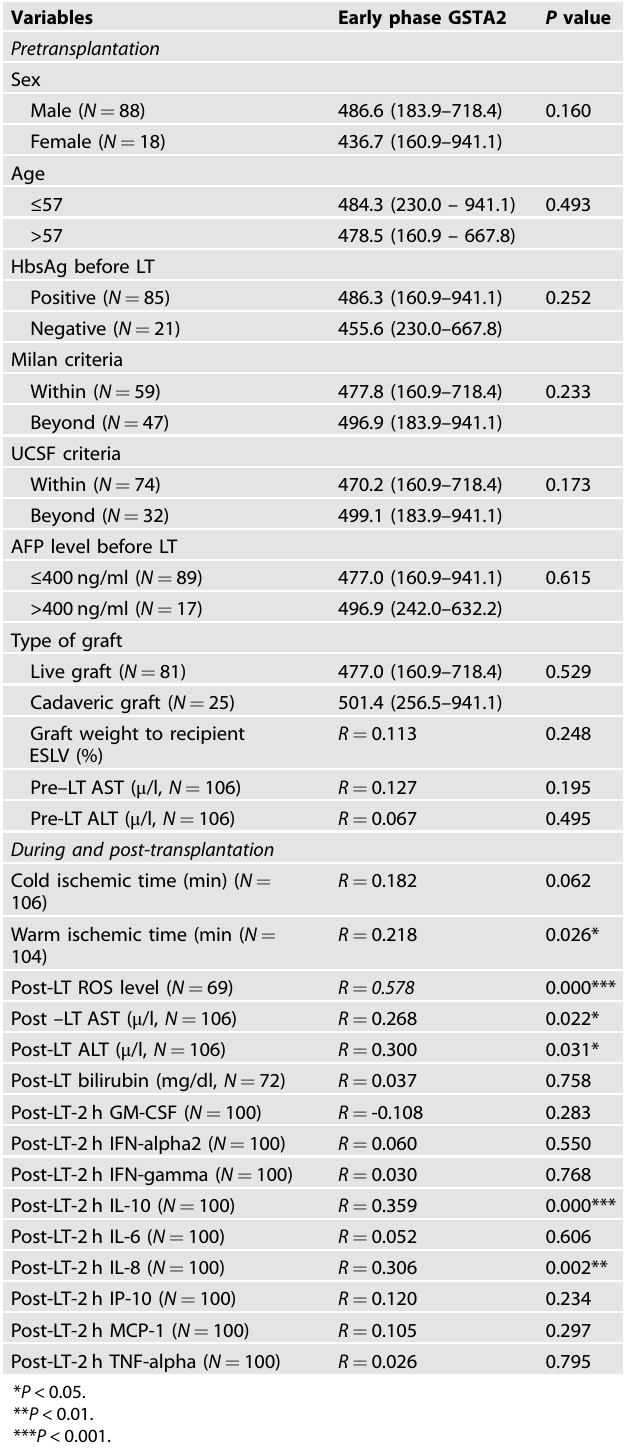
Table 1. Statistical analysis of early phase GSTA2 protein with clinical and experimental variables of HCC